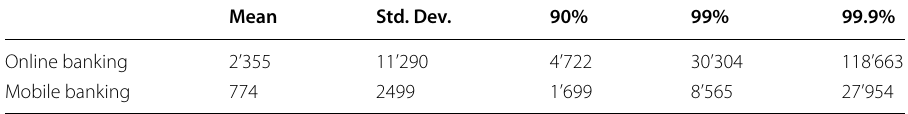
Table 3 Moments and quantiles of the fitted lognormal distributions in CHF for the online and mobile banking channel transactions